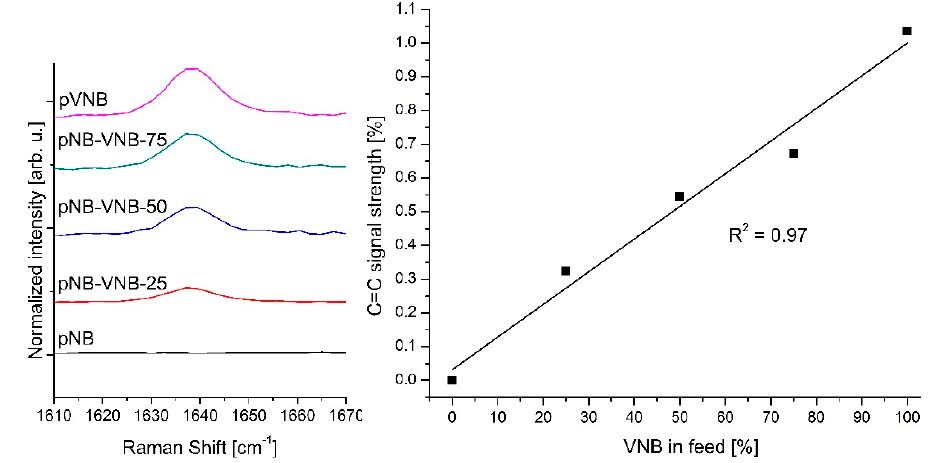
Figure 4. Raman analysis of the membranes. Left: A comparison of the Raman signals recorded over the C=C vibrational band. To facilitate the comparison and analysis leading these data, the C=C band intensity has been normalized relative to their common CH x band at 2950 cm − 1 (Figure S7). Right: The C=C signal intensity at 1637 cm − 1 is plotted against the VNB content in the monomer feed. Scanning Electron Microscopy (SEM) was used to view the cross-sections of the membranes (Figure 5). All membrane cross-sections show homogeneous dense films.